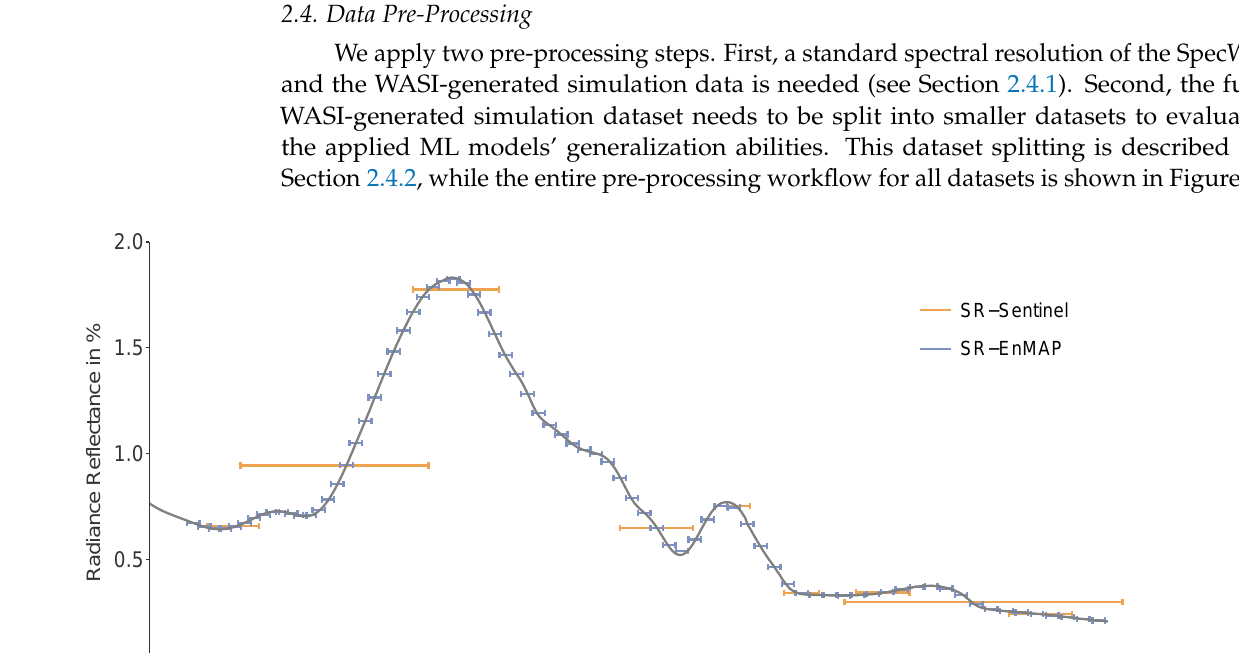
Figure 3. Sampling schema of the selected WASI parameters. Chl a refers to the Chlorophyll a , while P I are the remaining n = 11 parameters given in Table 2. I describes the control variable and I = 1... n − 1.